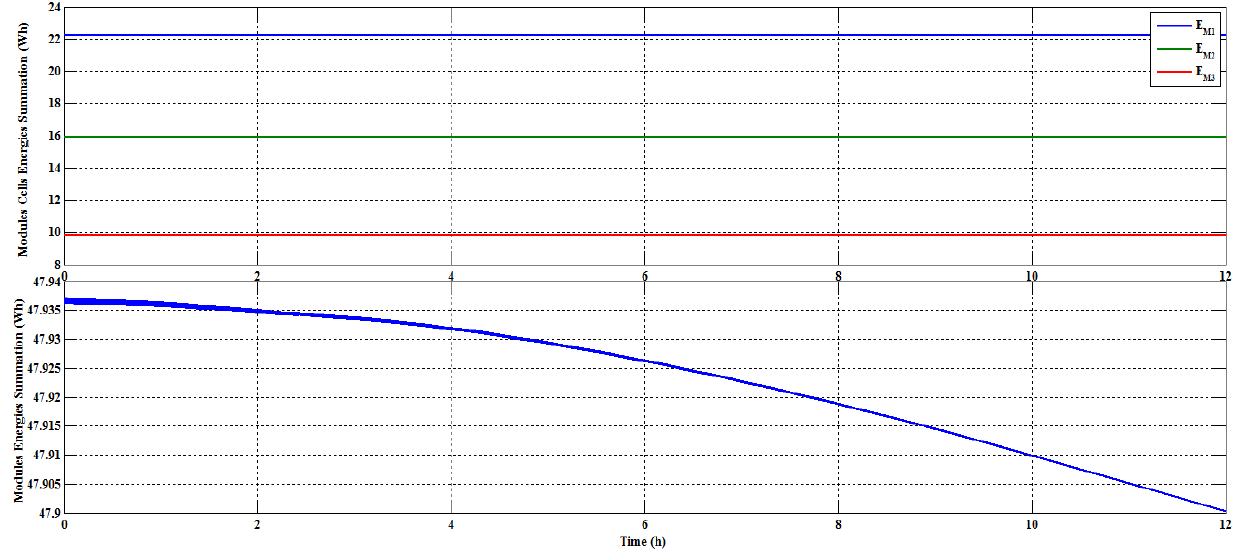
Figure 10. Simulation No. 1 (SSCs only) results: modules energies and energies summation.